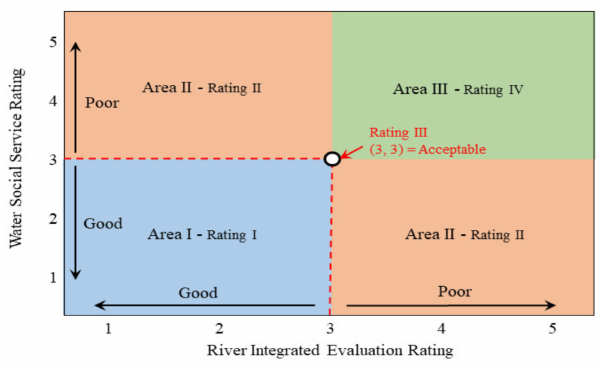
Figure 4. Matrix for water management comprehensive